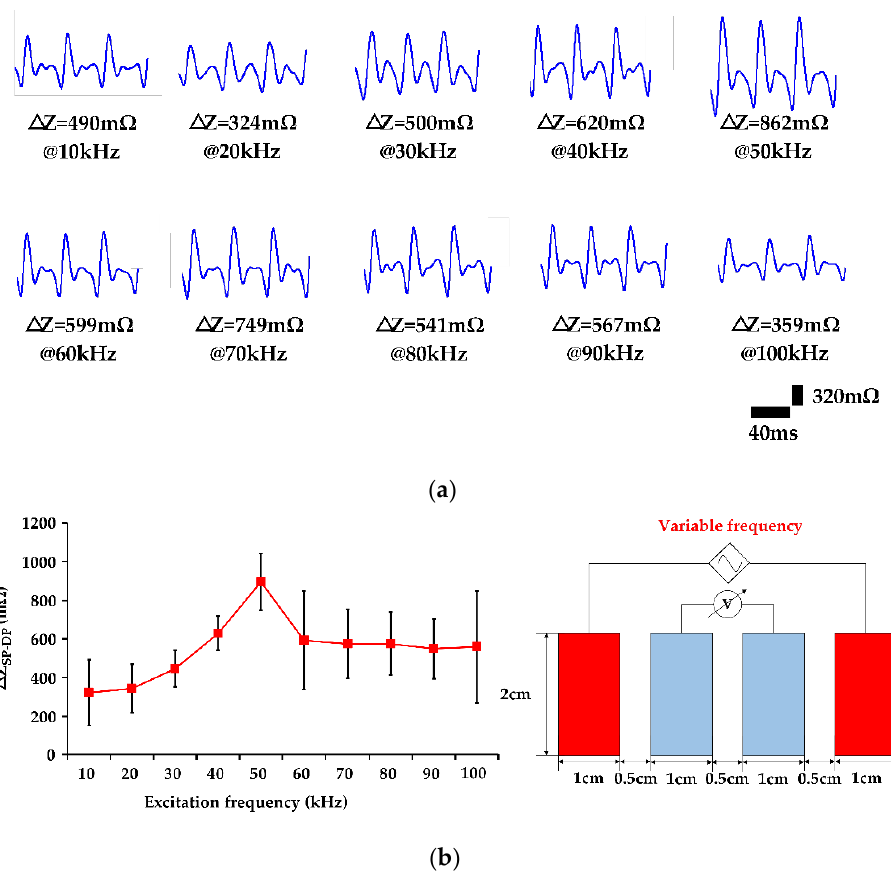
Figure 6. ( a ) IPG signals with excitation frequencies from 10 kHz to 100 kHz (Subject 1). ( b ) Statistical results for impedance variation in carotid pulse from 10 kHz to 100 kHz (n = 6).